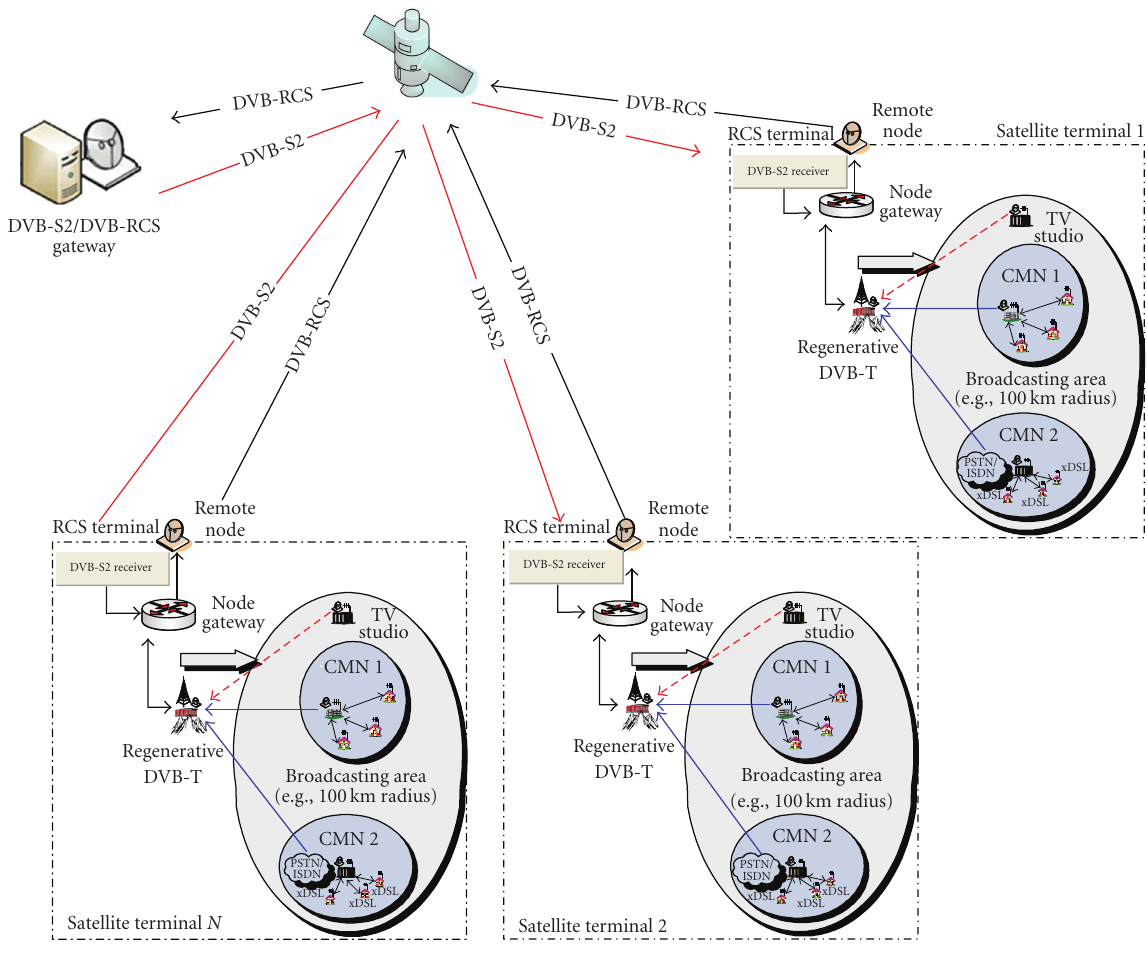
Figure 10: Configuration of the simulation test-bed for evaluating the performance of the hybrid terrestrial/satellite DVB/IP infrastructure.